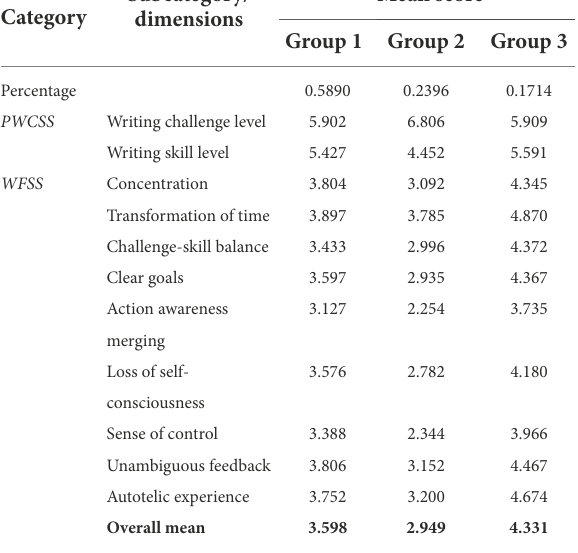
TABLE 3 Profile of three-group LCFA Model of WFSS.